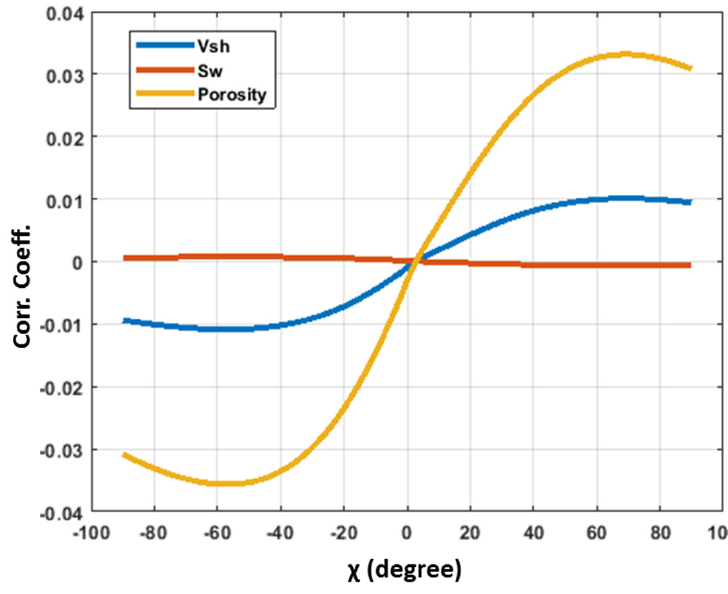
Figure 6. The EEI inversion correlation coe ffi cient versus χ angle cross ‐ plot.